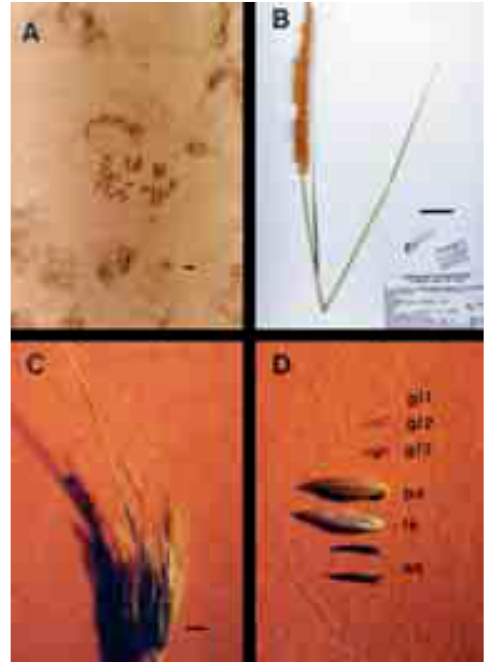
Figure 2 - BAG F92-176-1 (Interspecific hybrids between P. purpureum and P. glaucum ). A. Mitotic metaphase with 2n = 21 chromosomes; B. Specimens; C. Spikelet; D. Constituent of the spikelet: an (anthers), le (lemma), pa (palea), gl3 (3 rd glume), gl2 (2 nd glume), gl1 (1 st glume). The bars represent: A. 5 µ m; B. 5.6 cm; C and D. 2.3 mm. UFLA. Lavras, MG, Brazil,